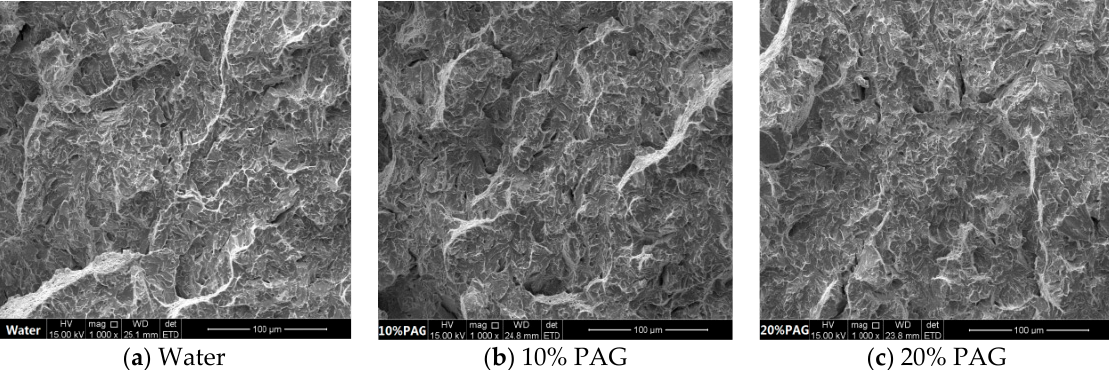
Figure 3. Impact fracture morphology of high chromium cast iron with different quenching mediums.